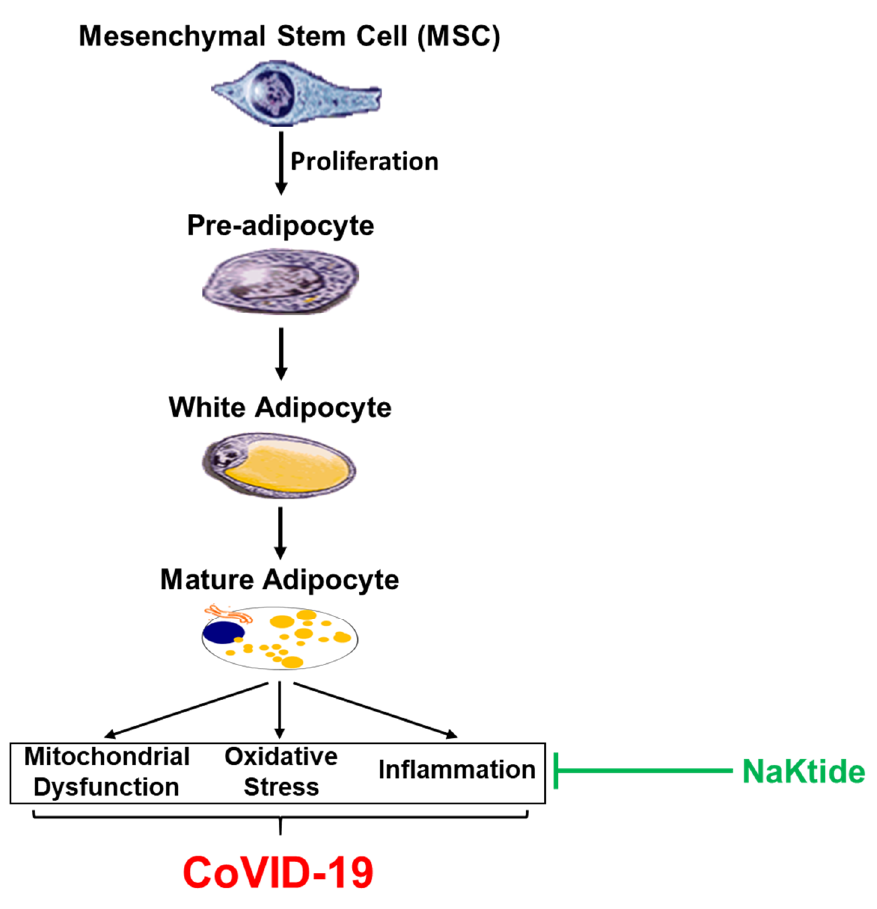
Figure 3. White adipocyte, Beige Adipocyte and Brown Adipocyte and COVID-19.